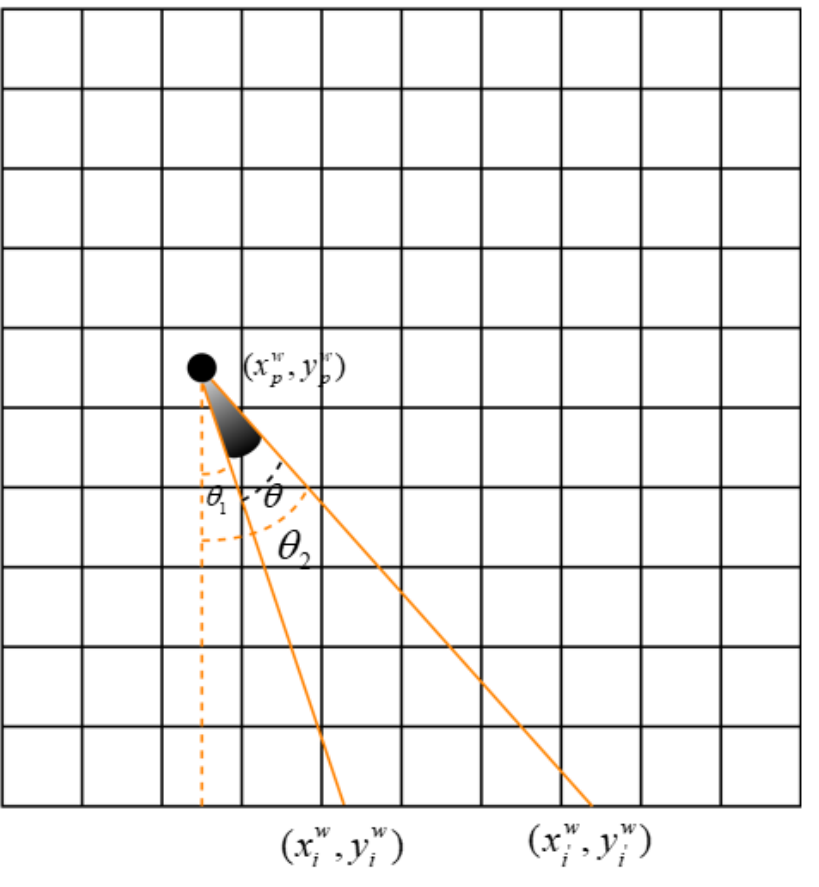
Figure 6. Schematic diagram of azimuth scattering angle range. The minimal azimuth scattering angle of the point cloud at scan i